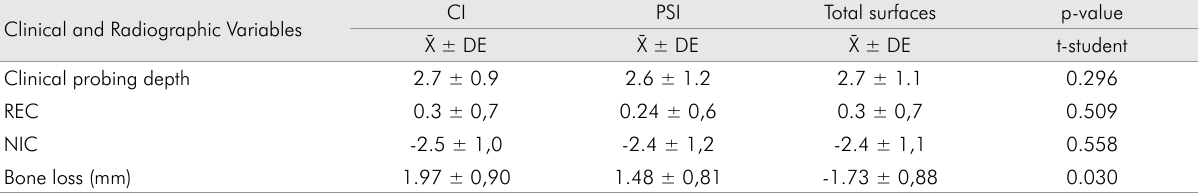
Table 3. Clinical and Radiographic results after 1 year of loading conventional implants (CI) and platform switching Implants